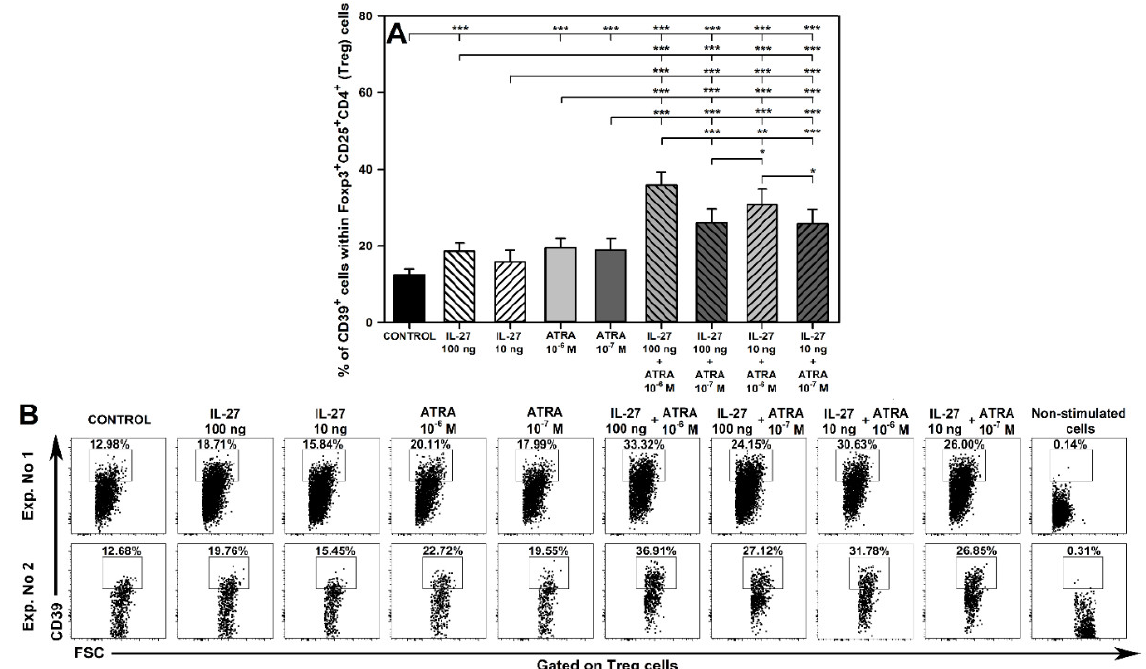
Figure 6. Effect two concentrations of IL-27 and all-trans-retinoic acid (ATRA) and their combina- tions on the relative count of CD39-expressing Foxp3 + CD25 + CD4 + regulatory T (Treg) cells under activation conditions ( A ). The parameter was determined in cell cultures incubated in the absence (CONTROL) and presence of IL-27 (100 and 10 ng/mL) and ATRA (10 − 6 and 10 − 7 M) for 72 h including concomitant stimulation with IL-2, anti-CD3, and anti-CD28 and re-stimulation with PMA and ionomycin for the last 5 h before harvest. Unstimulated cells served as a negative control for the cell activation. The relative count is expressed as a percentage of CD39-expressing cells within Foxp3 + CD25 + CD4 + T cell subset. Results are expressed as the mean (± S.D.) of two independent ex- periments with five mice per experiment (overall n = 10, * p < 0.05, ** p < 0.01, *** p < 0.001). Examples of dot plot cytograms for all treatments show the distribution of CD39-expressing cells within Foxp3 + CD25 + CD4 + T cell subset ( B ).